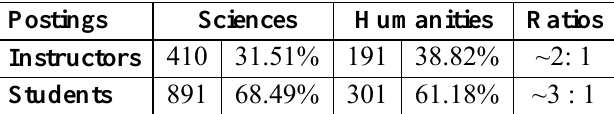
Number of Messages Posted by Instructors and Students